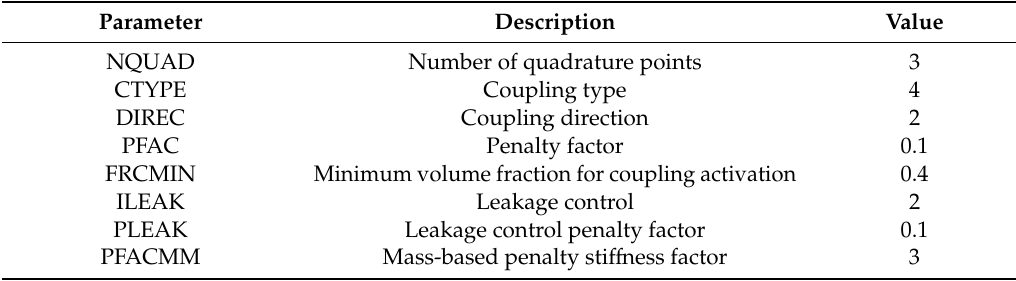
Table 3. Input values for the coupling definition.